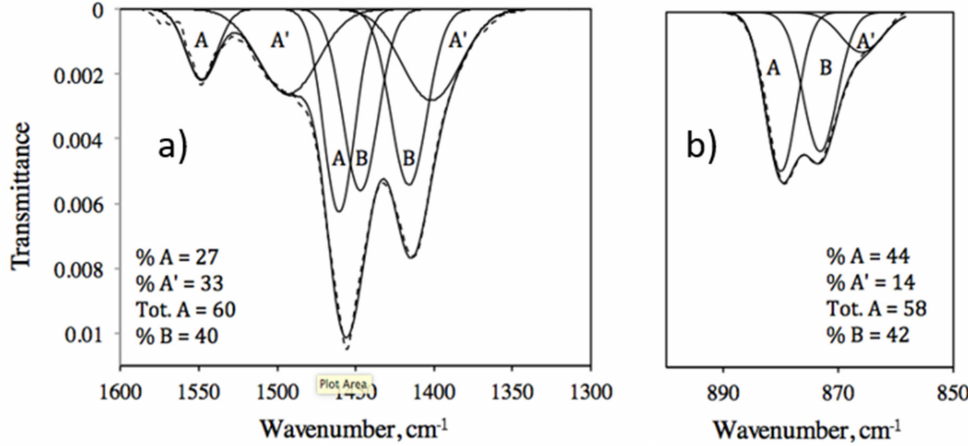
Figure 3. The carbonate asymmetric stretch ( ν 3 ) ( a ) and out-of-plane bend ( ν 2 ) ( b ) regions of the IR spectrum of KS-136 (unlabeled and with no Eu) [23].